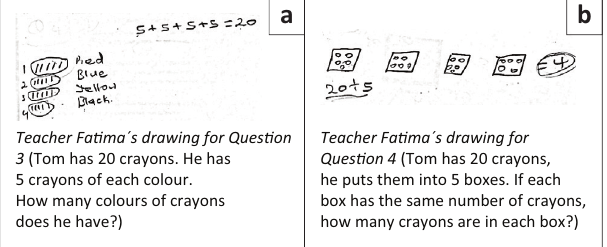
FIGURE 3: Teacher Fatima’s